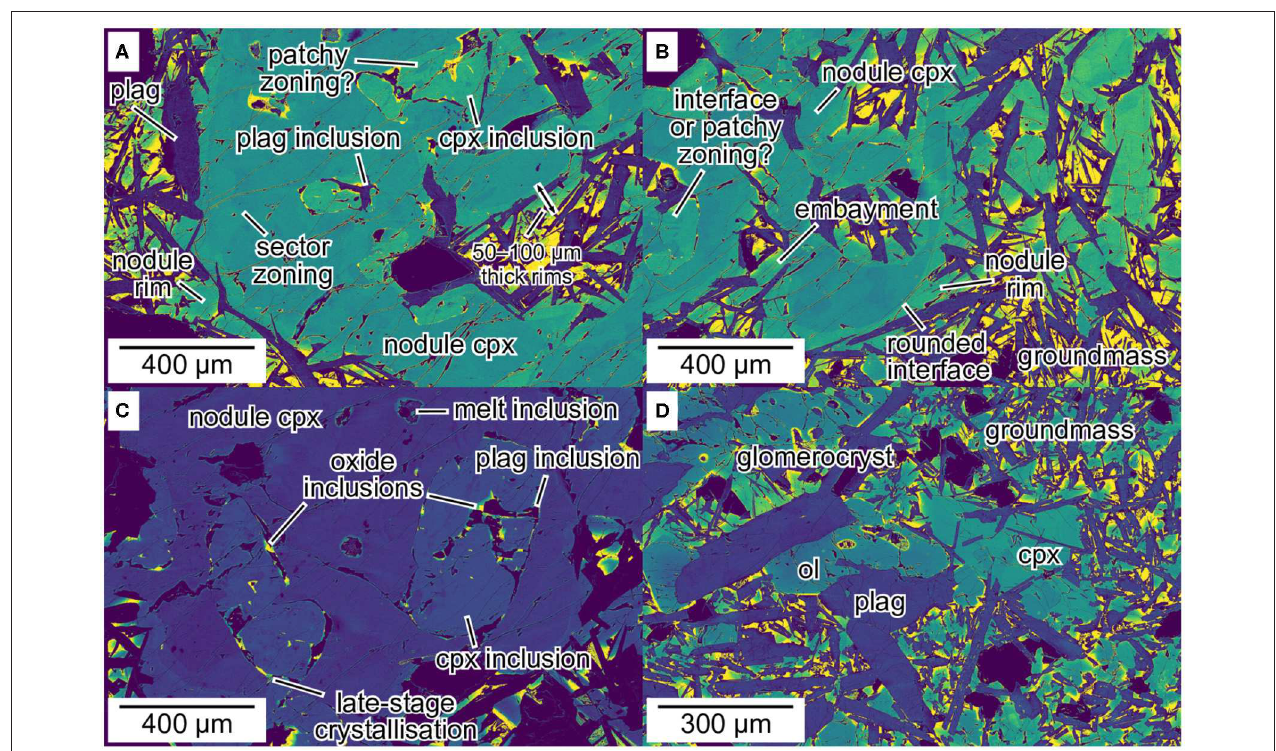
FIGURE 3 | Backscattered electron (BSE) images of mineral textures in sample JM27 from the Borgarhraun lava flow in North Iceland. Raw and additional representative images are provided in the Supplementary Material . (A,B) Nodule clinopyroxene cores have low but variable BSE intensities consistent with the presence of sector zoning. Nodule clinopyroxene rims and inclusions have slightly higher BSE intensities that increase greatly toward the groundmass and pockets of late-stage crystallization respectively. Nodule clinopyroxene rims and inclusions both contain irregular plagioclase inclusions. (C) Pockets of late-stage crystallization within clinopyroxene inclusions have very high BSE intensities and are associated with both plagioclase and oxide (titanomagnetite) inclusions. (D) Macrocrystic and glomerocrystic olivine, plagioclase and clinopyroxene occur in the crystalline lava groundmass. Plagioclase macrocrysts and glomerocrysts are typically larger than plagioclase crystals in the wehrlitic nodule. Clinopyroxene macrocrysts and glomerocrysts are often arranged in ophitic arrangements with plagioclase.